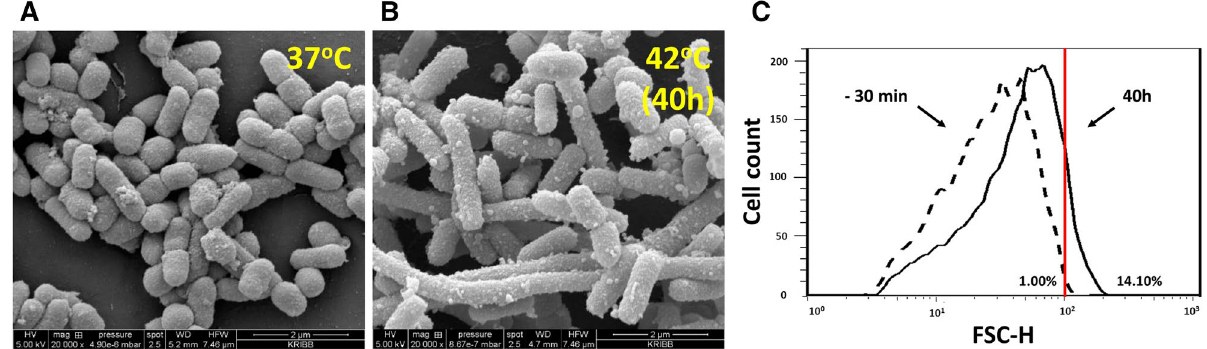
Figure 4. Morphological changes of E. coli during heatshock. Scanning electron micrographs of bacterial cells grown in the chemostat culture at 37 °C 30 min before the temperature upshift (− 30 min sample) ( A ) and 40 h after the temperature upshift to 42 °C ( B ). Cell size distributions determined using flow cytometry analysis ( C ). Dotted and solid lines denote cells at 37 °C 30 min before the temperature upshift and 40 h after the shift to 42 °C, respectively. The vertical red line represents the longest 1% size of the -30 min sample, which was used as the threshold. The mean forward scatter height (FSC-H) on the X axis represents the length of the rod-shaped bacteria. Percentages of elongated cell size in the total cells are 1% for the − 30 min samples and 14.10% for 40 h samples.